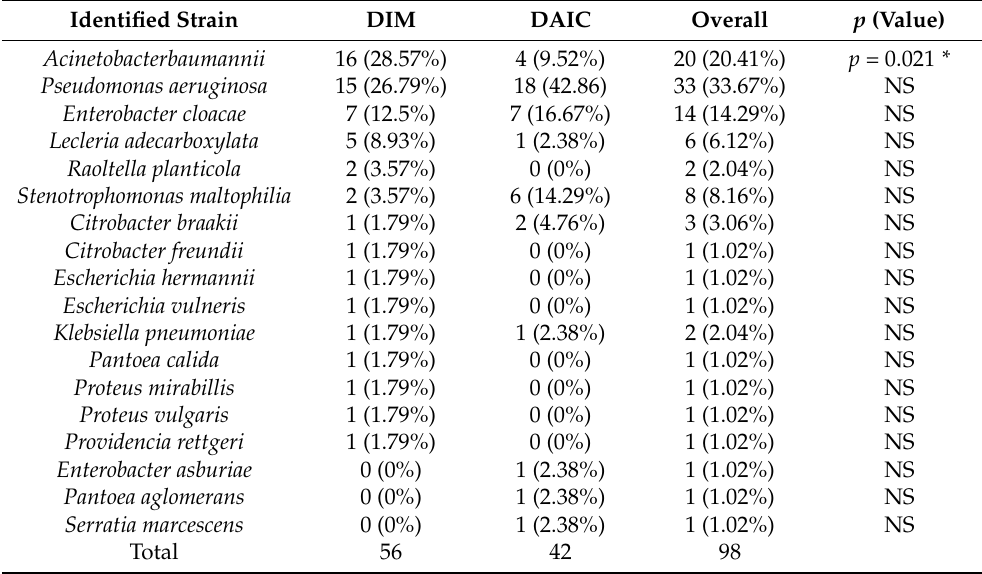
Figure 2. Distribution of identified bacteria according to Gram staining: n = 377. Of the total number of identified bacteria ( n = 377), 98 strains (26%) belonged to gram- negative rods. Table 1 shows that the most frequently isolated nosocomial gram-negative rod occurring in both departments is P. aeruginosa ( n = 33), followed by A. baumannii ( n = 20) and E. cloacae ( n = 14). Table 1. Frequency of selected gram-negative rods at both departments; ( n = 98 total; n = 56, DIM; n = 42, DAIC) (statistically evaluated by chi-square test). (NS—not significant, *—significant).